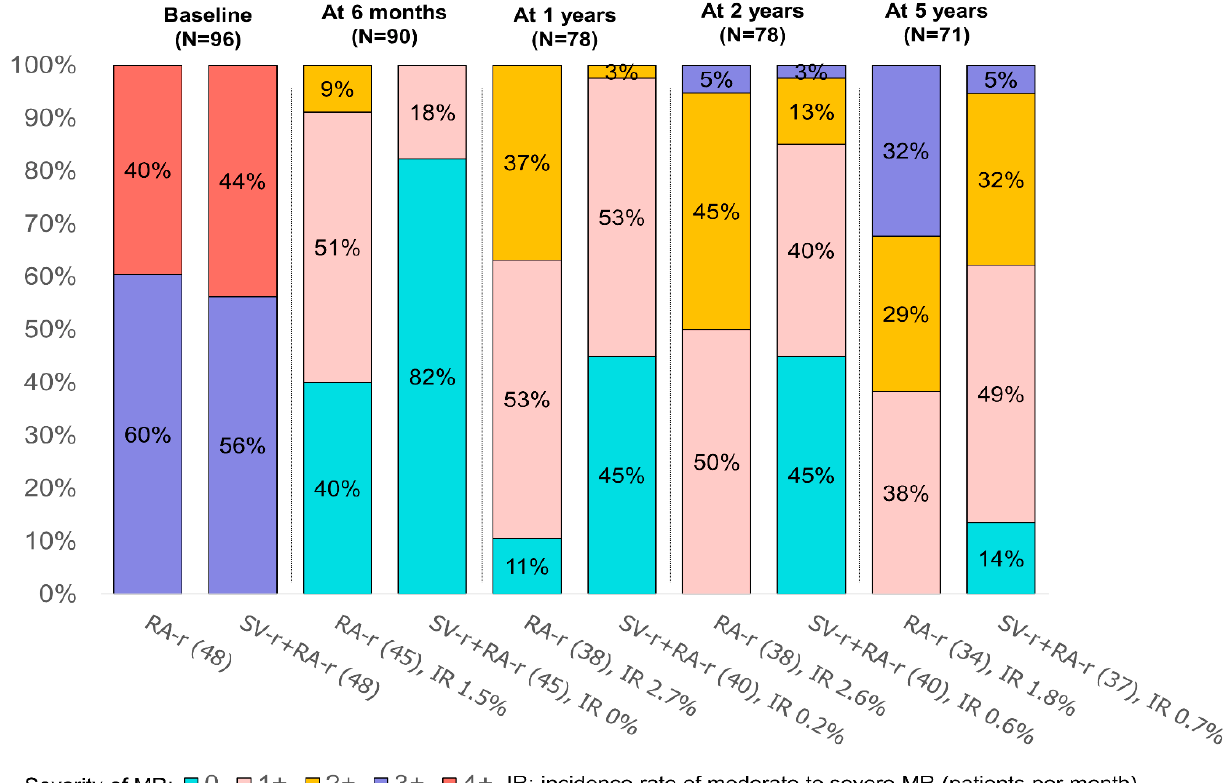
Figure 2. Degrees of mitral regurgitation at baseline and at 6 months, 1 year, 2 years, and 5 years after mitral valve repair, represented as percentages, in the two groups: subvalvular repair combined with restrictive annuloplasty repair (SV-r + RA-r group) and restrictive annuloplasty repair alone (RA-r group).